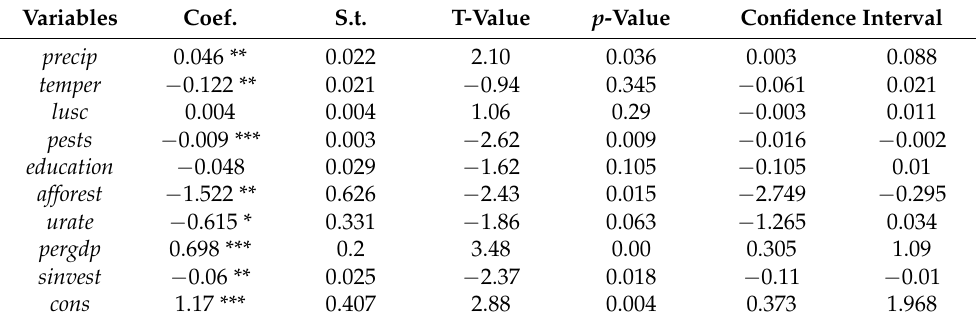
Table 7. Empirical analysis results of influencing factors of forest carbon sink efficiency. Variables